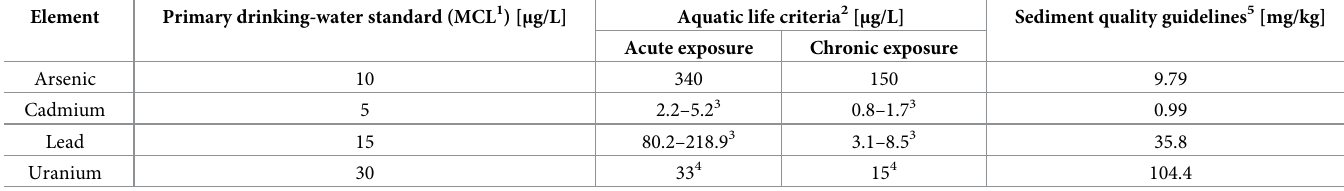
Table 2. Drinking water-quality standards, aquatic toxicity reference values, and sediment quality guidelines for elements investigated in this study.